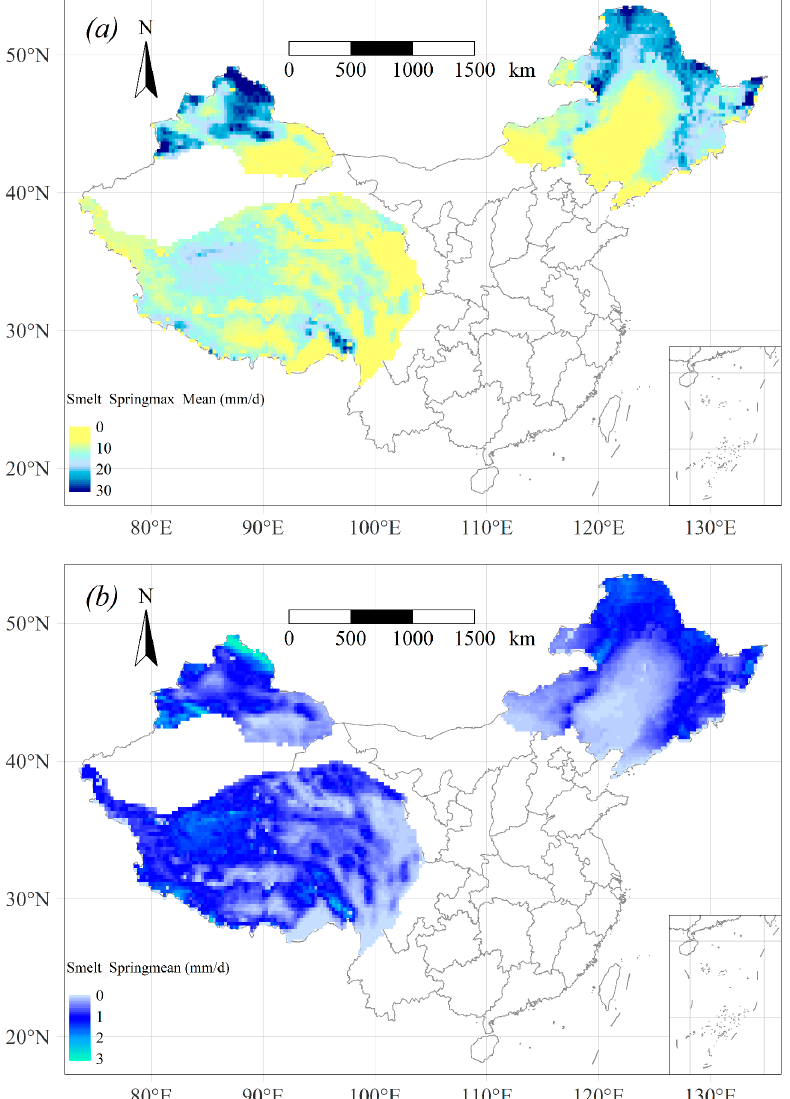
Figure 3. Snowmelt rate in spring across the three main stable snow cover regions of China for the period of 1981–2020. Shown are the distributions of ( a ) maximum and ( b ) mean values. The unit mm/d refers to mm per day.